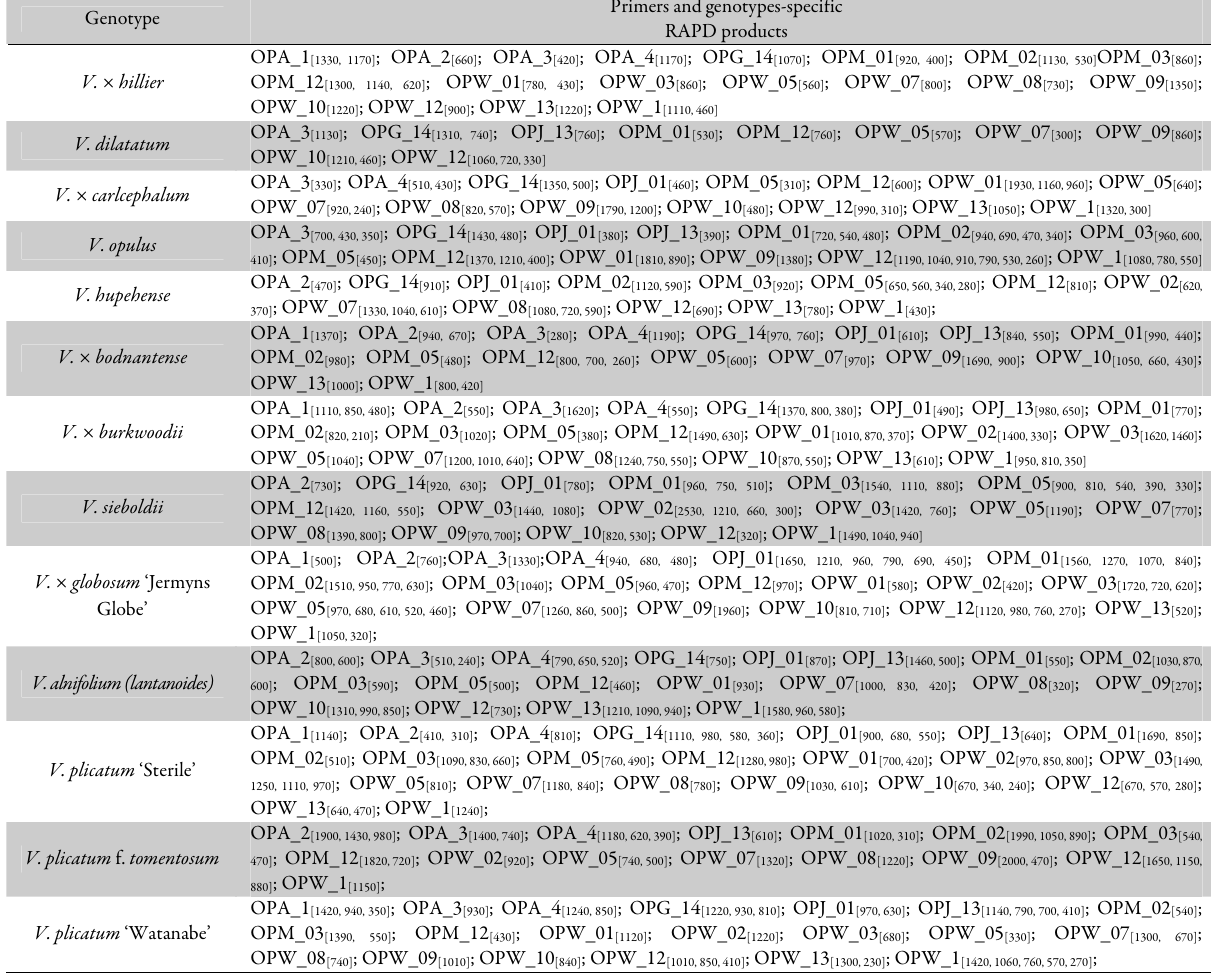
Tab. 2. Genotype-specific RAPD products generated for 13 genotypes of Viburnum investigated (profiled) Genotype